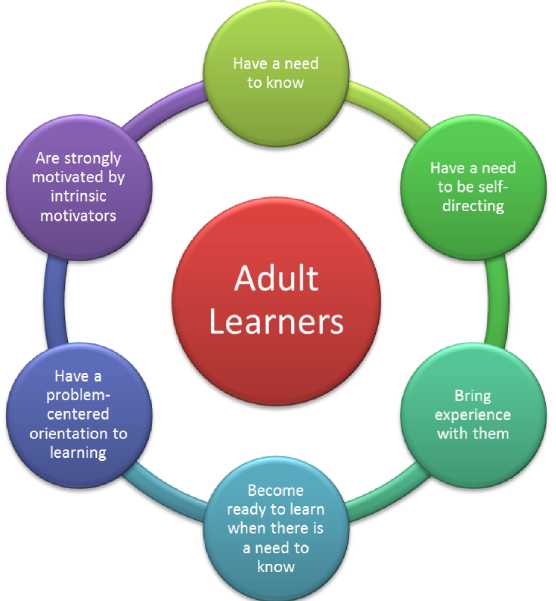
Figure 3. Assumptions about adults as learners